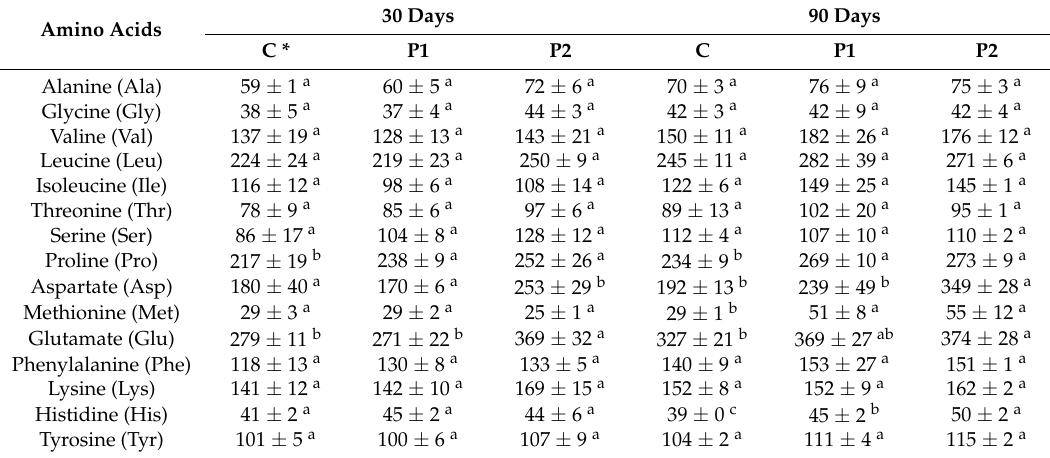
Table 5. Concentration of individual free amino acids (FAA) of Beyaz cheeses ( n = 3) (mg 100 g − 1 ). 30 Amino Acids